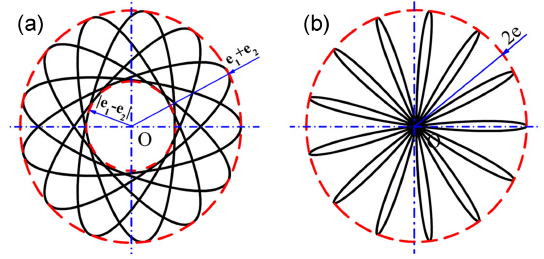
Figure 13. Motion curve of O 2 when ω 1 (cid:54)= ω 2 and ω 1 · ω 2 < 0 ( ω 1 /ω 2 = 6 / − 7). (a) e 1 (cid:54)= e 2 , (b) e 1 = e 2 = e .